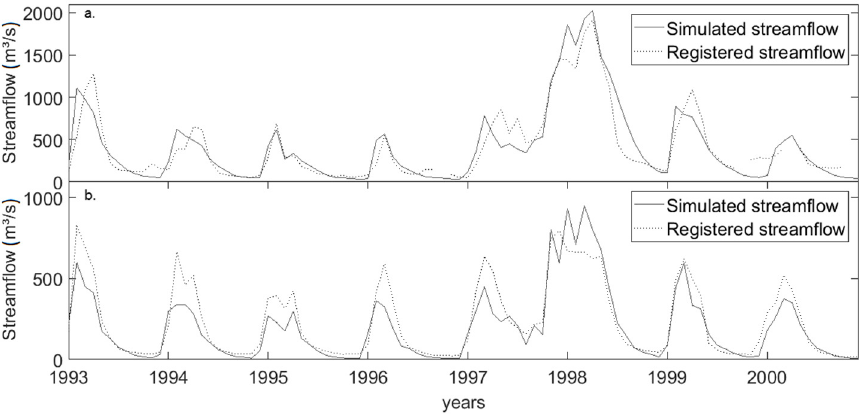
Figure 2. Monthly time series for the “Daule en la Capilla” ( a ) and “Zapotal en Lechugal” ( b ) stations during the calibration period (1993–2000).